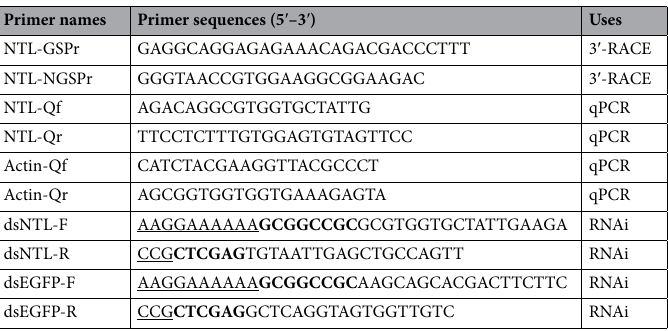
Table 1. Primers for RACE, qPCR and RNAi. Underlined were protecting nucleotides and bold ones were Not I and Xho I restriction